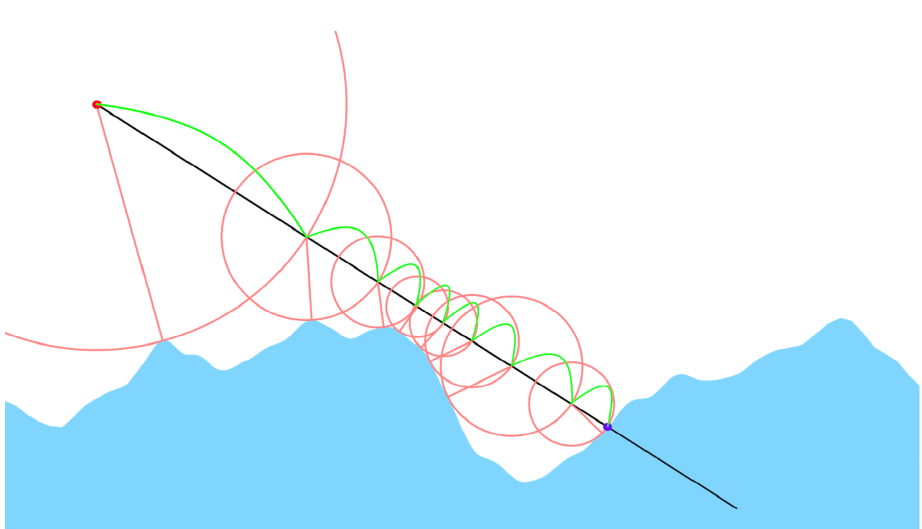
Figure 3. The iterative mechanism of raymarching to find an intersection. The blue object is the implicit surface. The black line is the ray. The red point is the ray origin and purple point is the detected intersection. The red circles represent the distances sampled from the distance field and the green curves represent the ‘march forward’ each